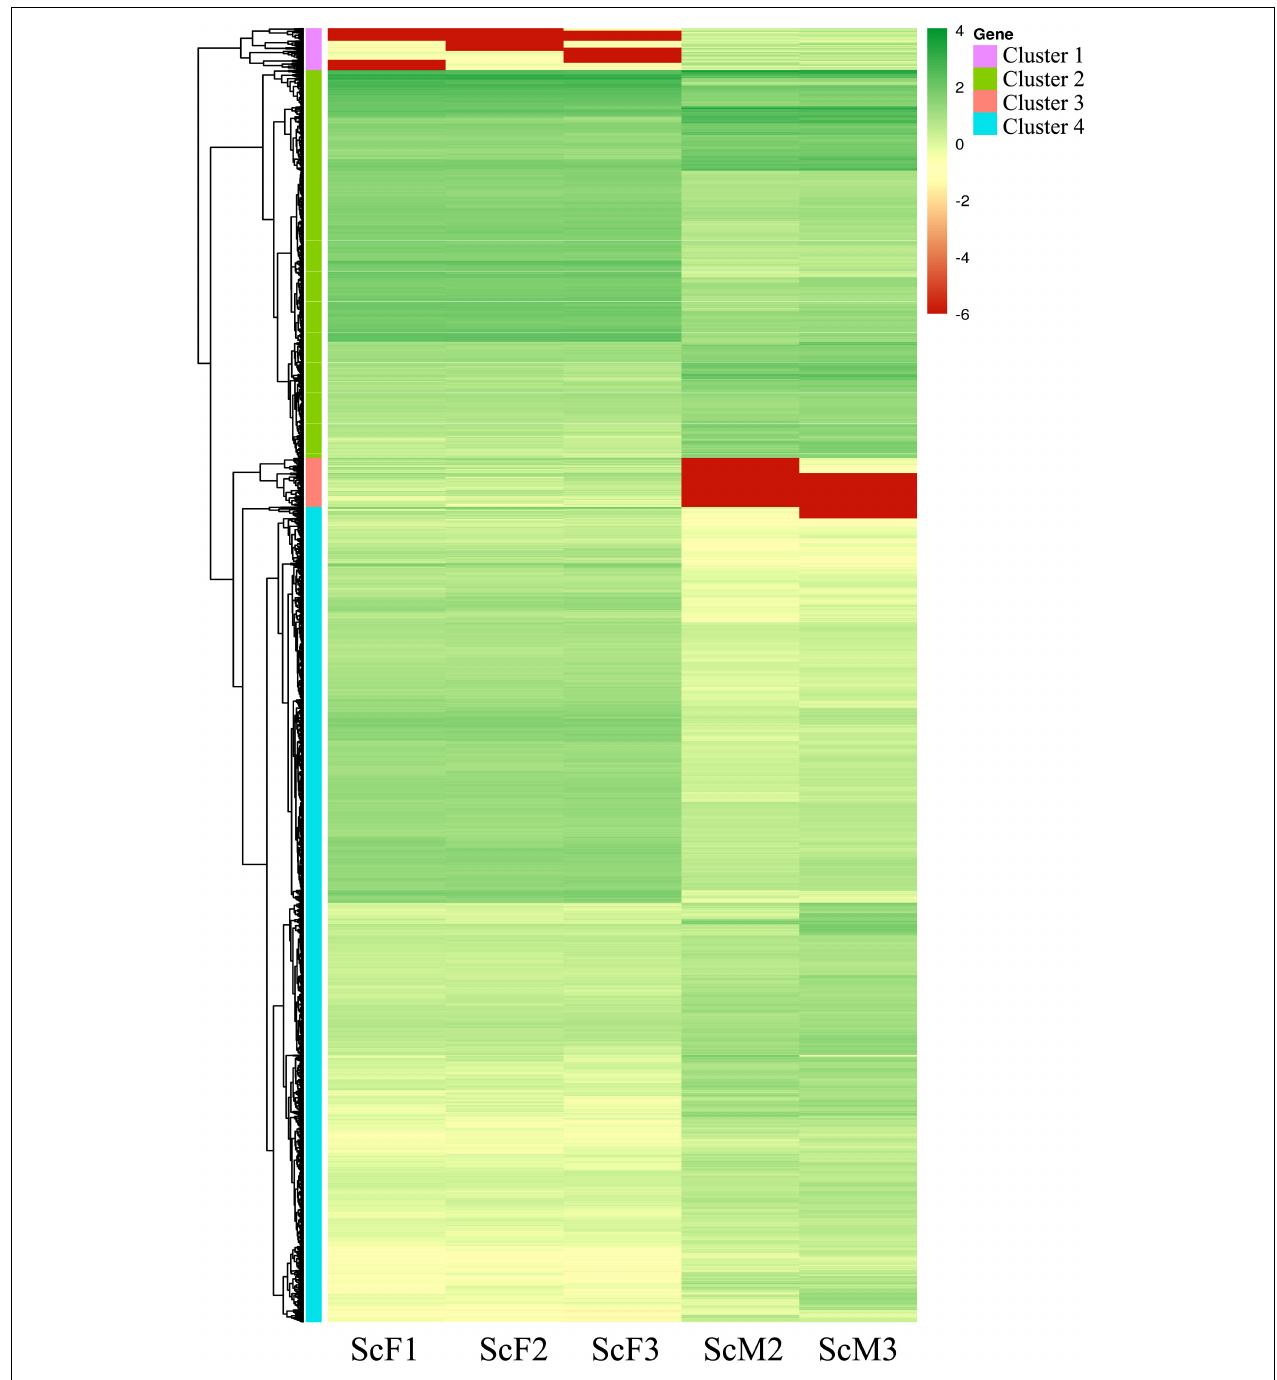
FIGURE 5 | Heatmap of DEGs in female and male gonads. Different columns represent different samples, different rows represent different genes, and the colors represent the gene expression levels [log10(FPKM + 0.000001)] in the samples. Green represents highly expressed genes, and red represents weakly expressed